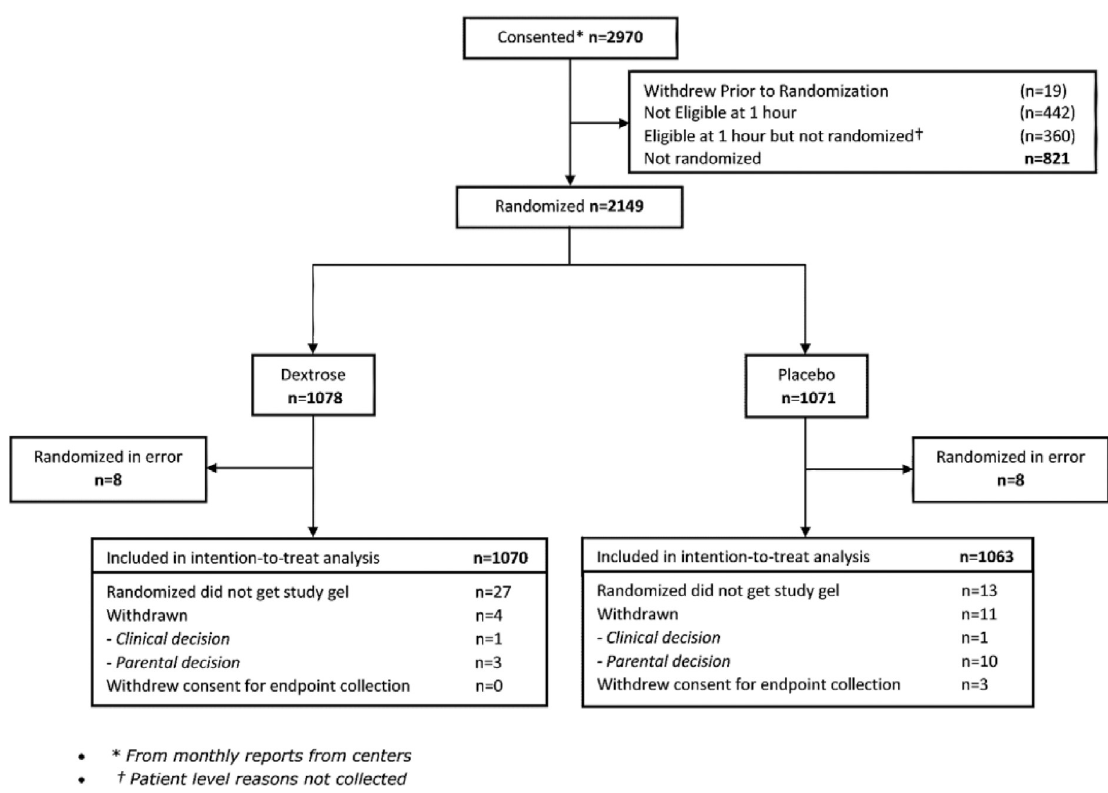
Fig 1. Participant